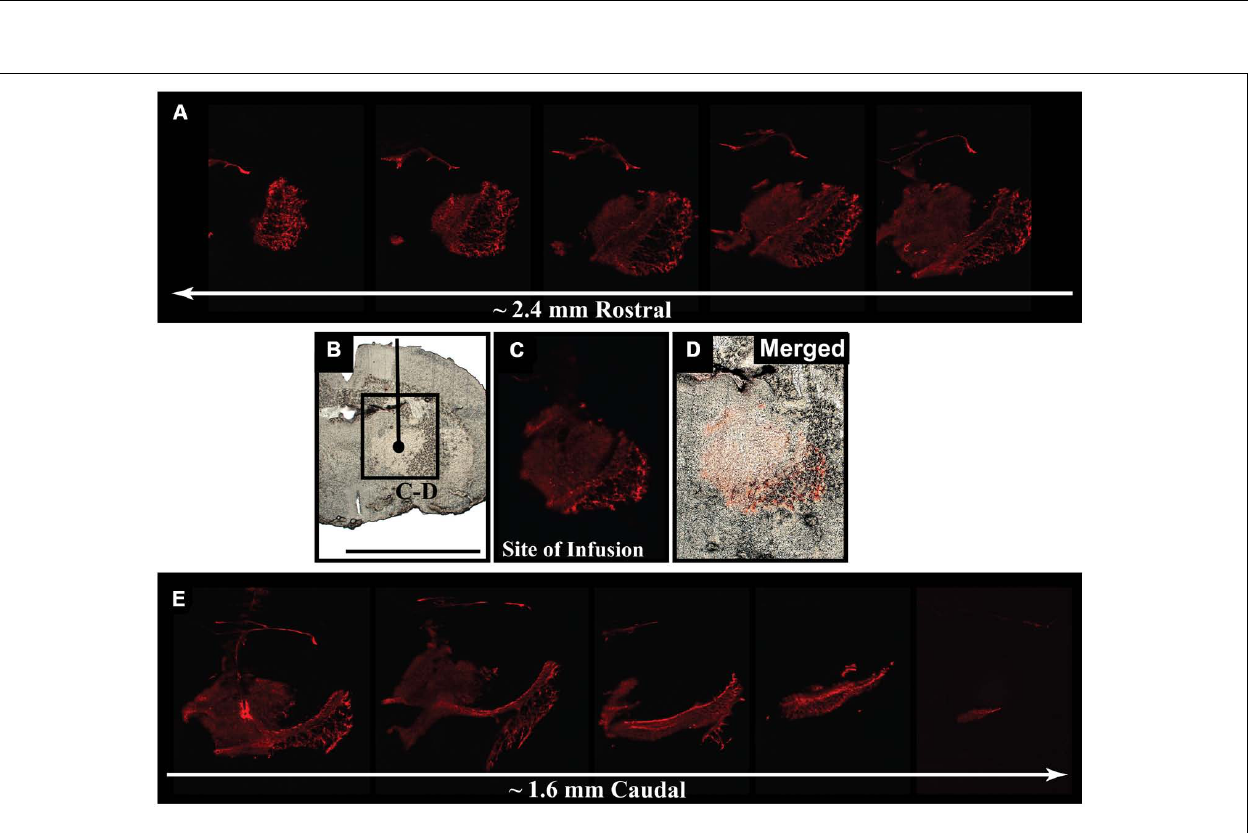
fluorescence reached approximately 2.4 mm rostral and 1.6 mm caudal from the site of infusion, suggesting efficient movement of these particles throughout the brain after CED. Scale bar: B–D = 5